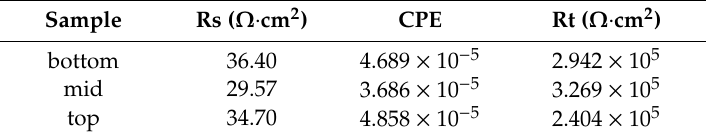
Figure 18. Comparison of electrochemical corrosion test results: ( a ) CPE value and ( b ) Rt value. Table 4. Numerical results of the electrochemical impedance experiment.